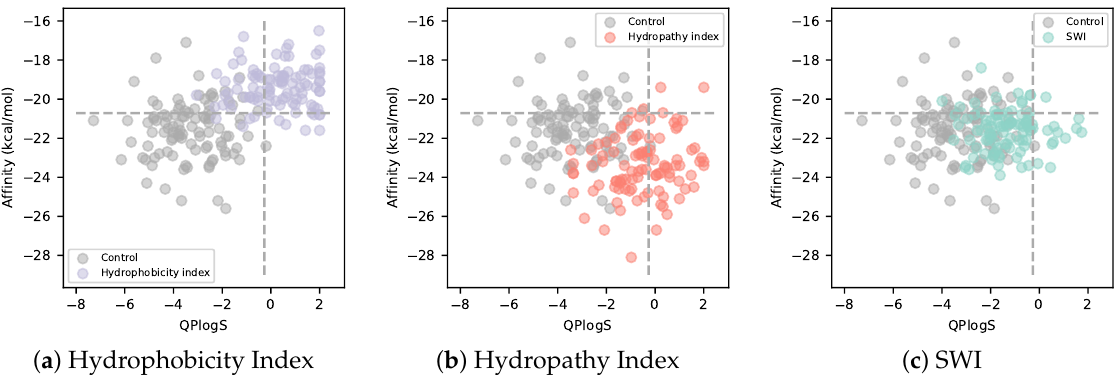
Figure 6. Scatter plots of binding affinity and logS for various weights of sequences designed in AfDesign using three solubility indices. Each point shows the binding affinity and logS of a sequence designed in AfDesign with a weight of 0.5 using the Hydrophobicity Index ( a ), Hydropathy Index ( b ), and Solubility-Weighted Index (SWI) ( c ) as solubility indices in the loss function. Gray dots show the binding affinity and logS of sequences designed in AfDesign without a solubility index. The horizontal dashed line shows the average binding affinity of the p53 peptide. The vertical dashed line shows the logS values for the p53